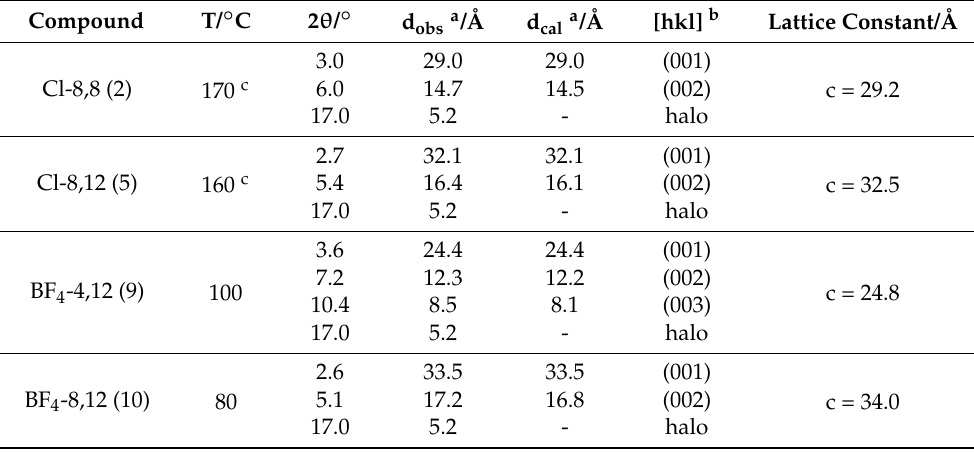
Table 3. X-ray diffraction results for selected compounds from each